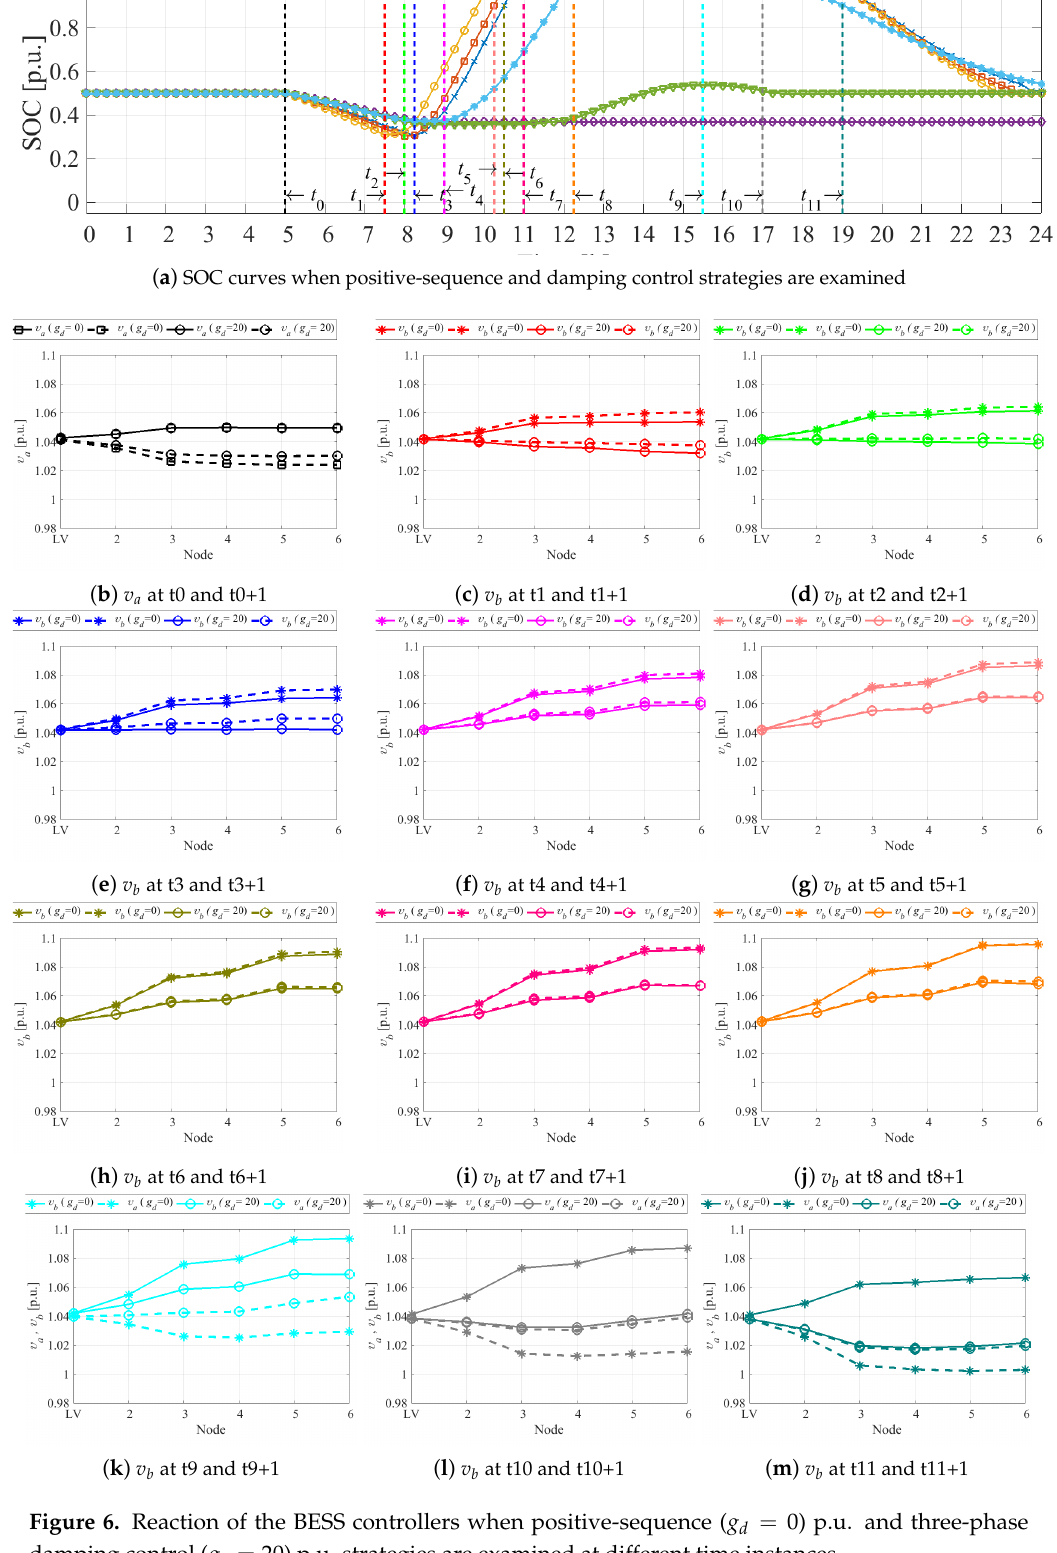
Figure 6. Reaction of the BESS controllers when positive-sequence ( g d = 0) p.u. and three-phase damping control ( g d = 20) p.u. strategies are examined at different time